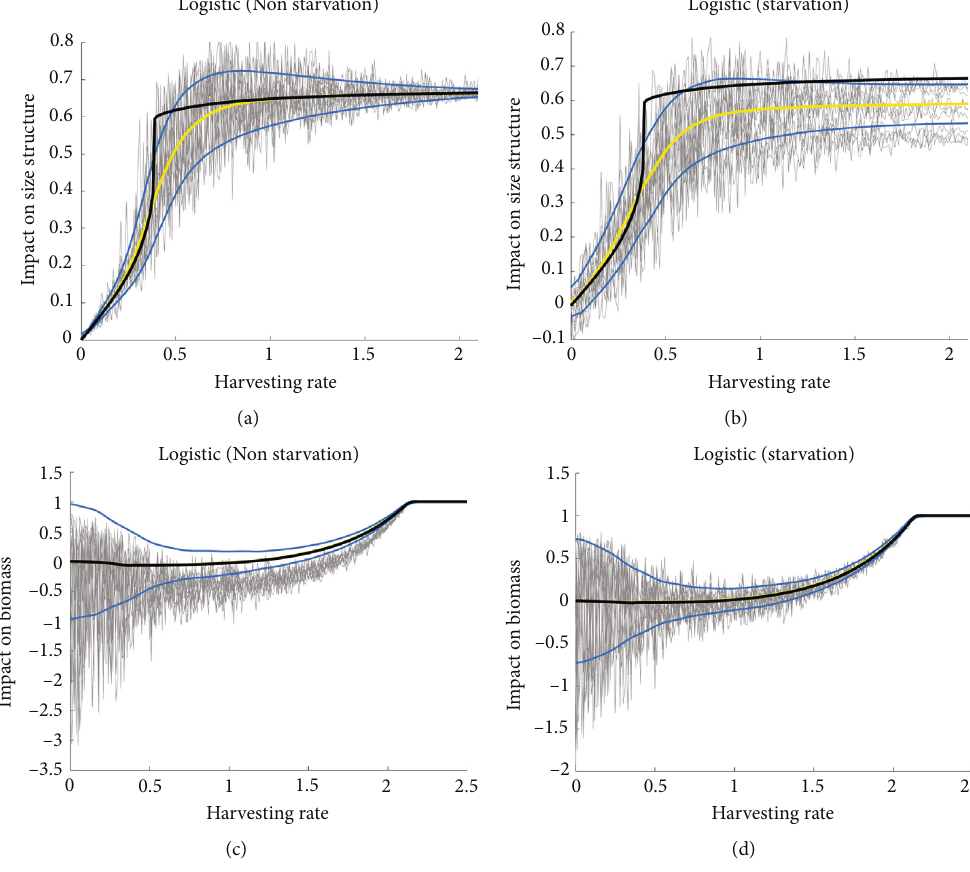
Figure 11: Impact on size structure and biomass of logistic growth rate without starvation (a, c) and with starvation (b, d) at steady state w.r.t. harvesting rate. The grey trajectories show the impact on size structure and biomass from di ff erent simulations for the stochastic case. The yellow curve represents the mean value of the simulations. The light blue curves represent the interval of standard deviation (68%). The black curve represents the impact on size structure and biomass for the deterministic case. Equations (17) and (18) are used to derive the above graphs for the impact on size structure and biomass,